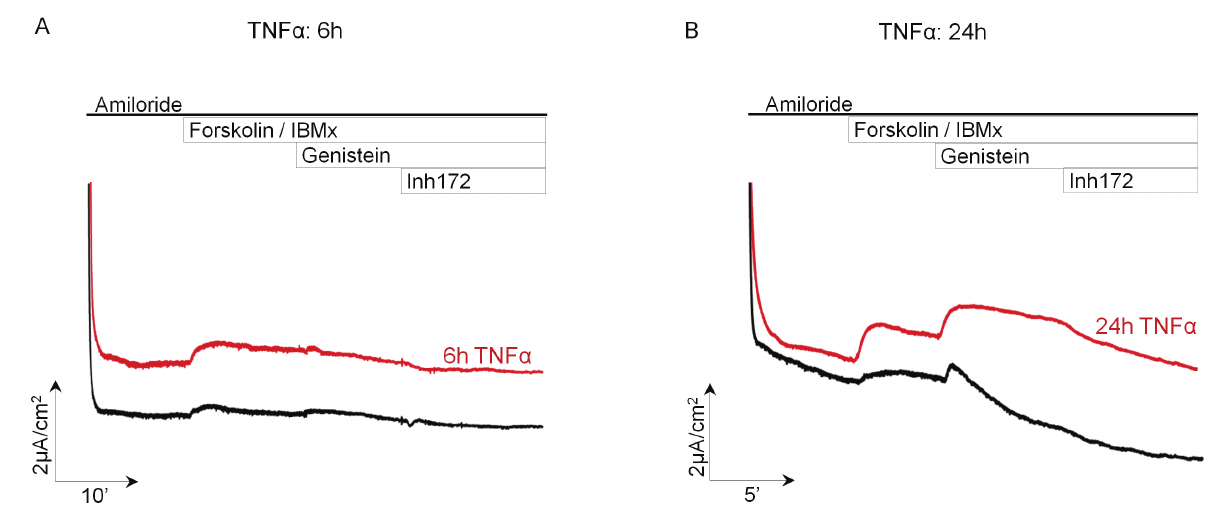
Figure 6. TNF α treatment of primary HBE cells increases CFTR-dependent chloride secretion. Short-circuit current experiments on air-liquid cultures of HBE cells from a F508del/F508del CF patient. Amiloride, an inhibitor of Na + current (ENaC), was present throughout the experiment. Forskolin (10µM) + IBMX (100µM) were added apically and basolaterally to increase the intracellular cAMP to activate the cAMP- dependent currents, followed by addition of genistein (50µM), a phytoestrogen known to potentiate I . The inhibitor of I , inh-172 (10µM), CFTR CFTR was added to the apical Ussing chamber to attest to the presence of I . A . Treatment of cells for 6h with 50ng/ml of TNF α induced cAMP- CFTR dependent, inh172 sensitive chloride current of higher magnitude than control non-treated cells. B . Treatment of cells for 24h with 50ng/ml of TNF α induced cAMP-dependent chloride current, potentiated by genistein and abolished by inh172 of higher magnitude than control cells. Black tracings represent Isc measurements in control untreated cell cultures whereas red tracings visualize Isc measurements in epithelia treated with TNF α